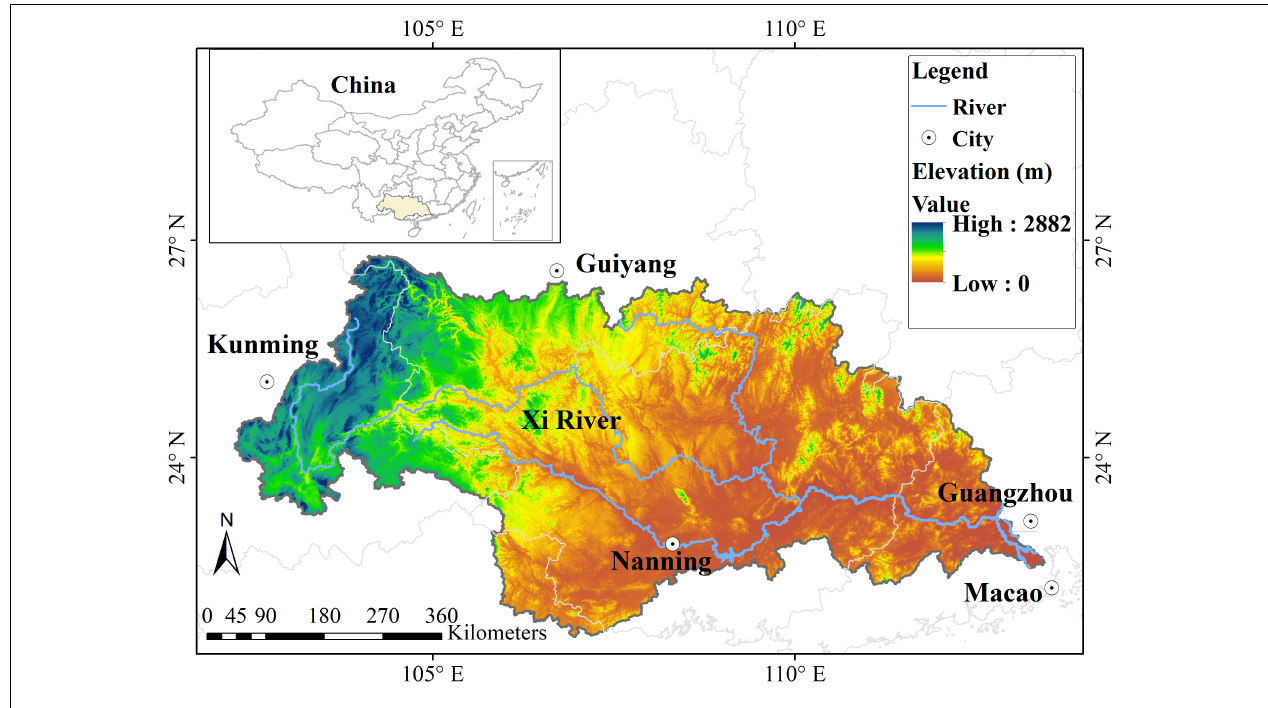
FIGURE 1 | Location of the Xi River